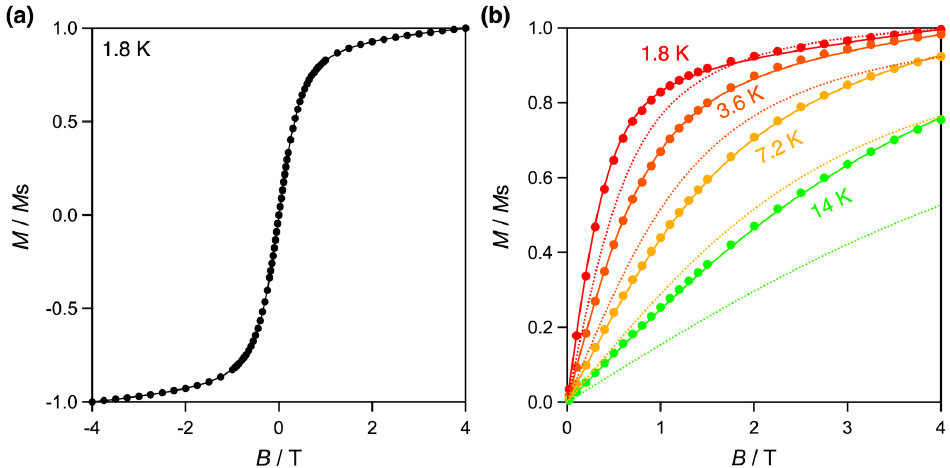
Figure 5. Magnetic field-dependent magnetization of compound 1 . ( a ) Loop at 1.8 K and ( b ) curves at 1.8 K (red line), 3.6 K (orange line), 7.2 K (yellow line), and 14 K (lime-green line). The solid-colored lines show the simulation curves using S = 5/2, L = 5, g J = 4/3, λ = − 360 cm − 1 , D = − 0.9 cm − 1 , whereas the dotted lines are fitting curves without the D term.